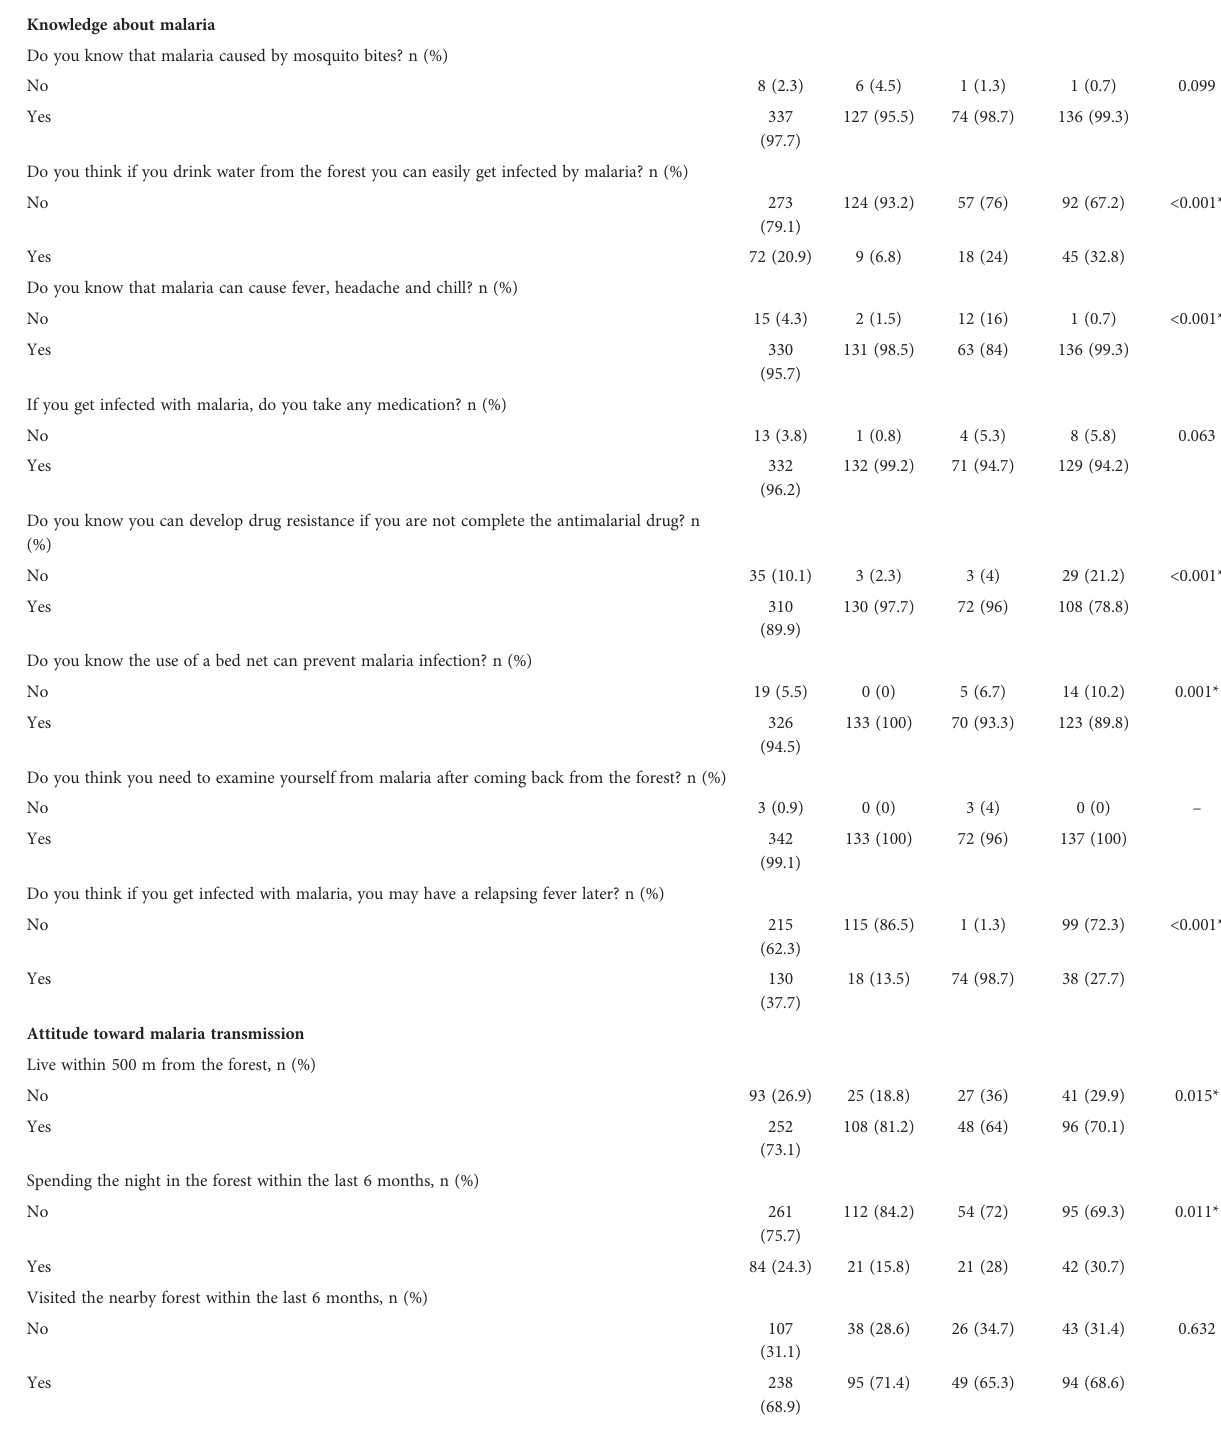
TABLE 2 Knowledge, attitudes, and practices (KAP) on malaria among respondents in three forest-goer communities in Mukdahan Province, Northeastern Thailand in 2019.